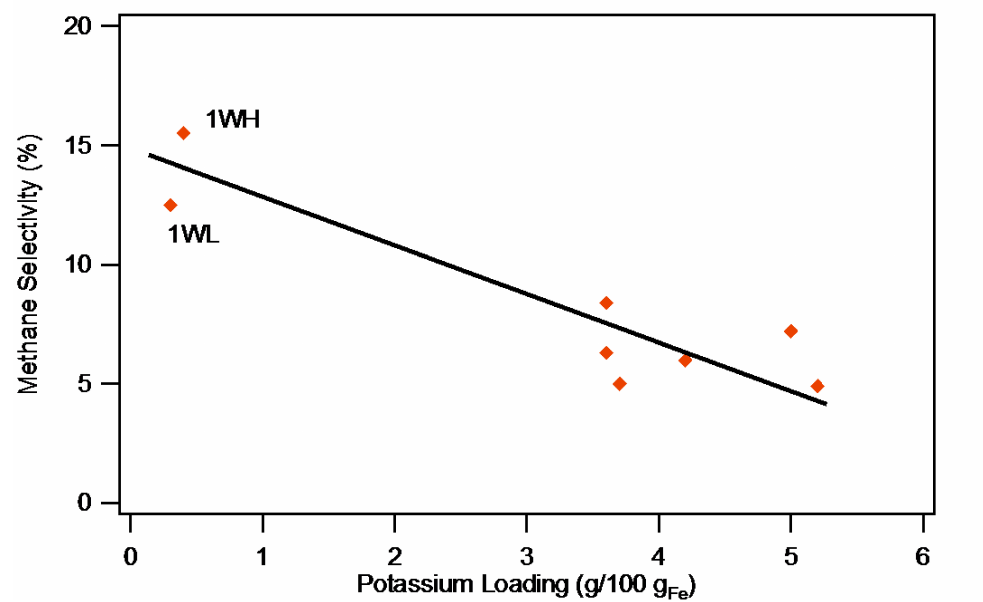
Figure 10. CH 4 selectivity versus potassium loading for SDP